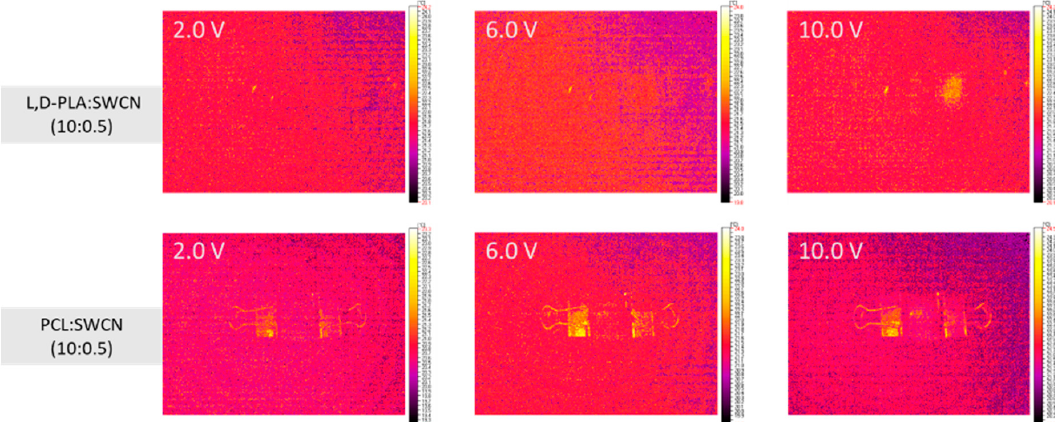
Figure 9. Thermal images for films composed of L,D-PLA, and PCL with SWCN at the ratio 10:0.5 w/w at 2.0 V, 6.0 V, and 10.0 V.